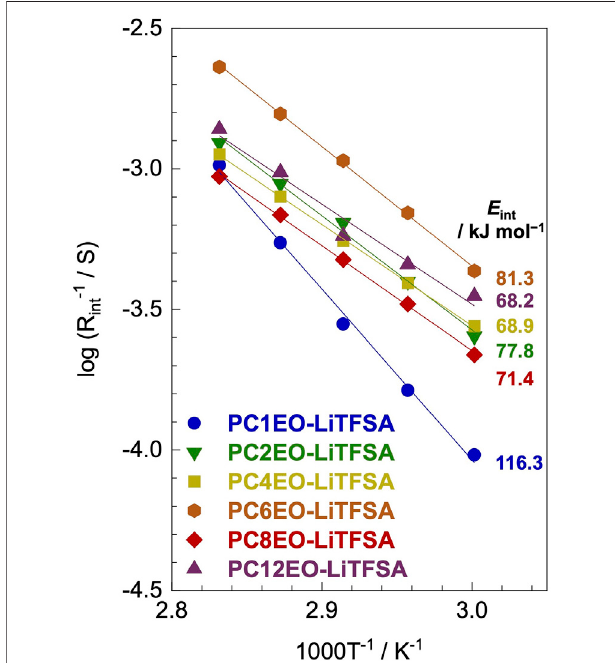
FIGURE 5 | Reciprocal of lithium-metal electrode-polymer electrolyte interfaceresistance( R int )forPCmEO-LiTFSAelectrolytes( m =1,2,4,6,8,and 12) plotted against 1000 T − 1 . Arrhenius fi tting lines are shown in solid lines. The measurements were performed at the temperature range of 60 − 80 ° C using a lithium symmetric